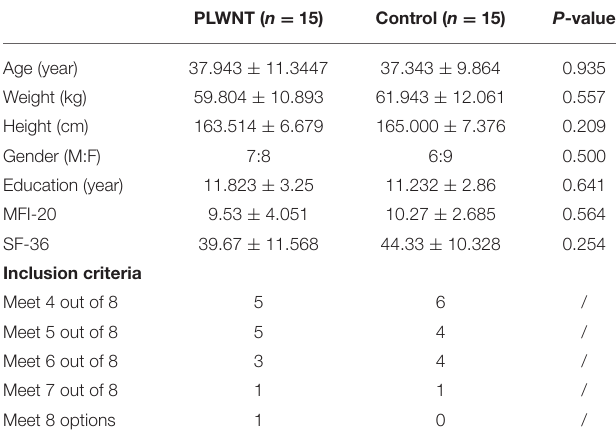
TABLE 1 | Demographic and clinical characteristics of the patients. TABLE 2 | Compared with the control group, the brain areas enhanced and reduced ALFF value in the PLWNT